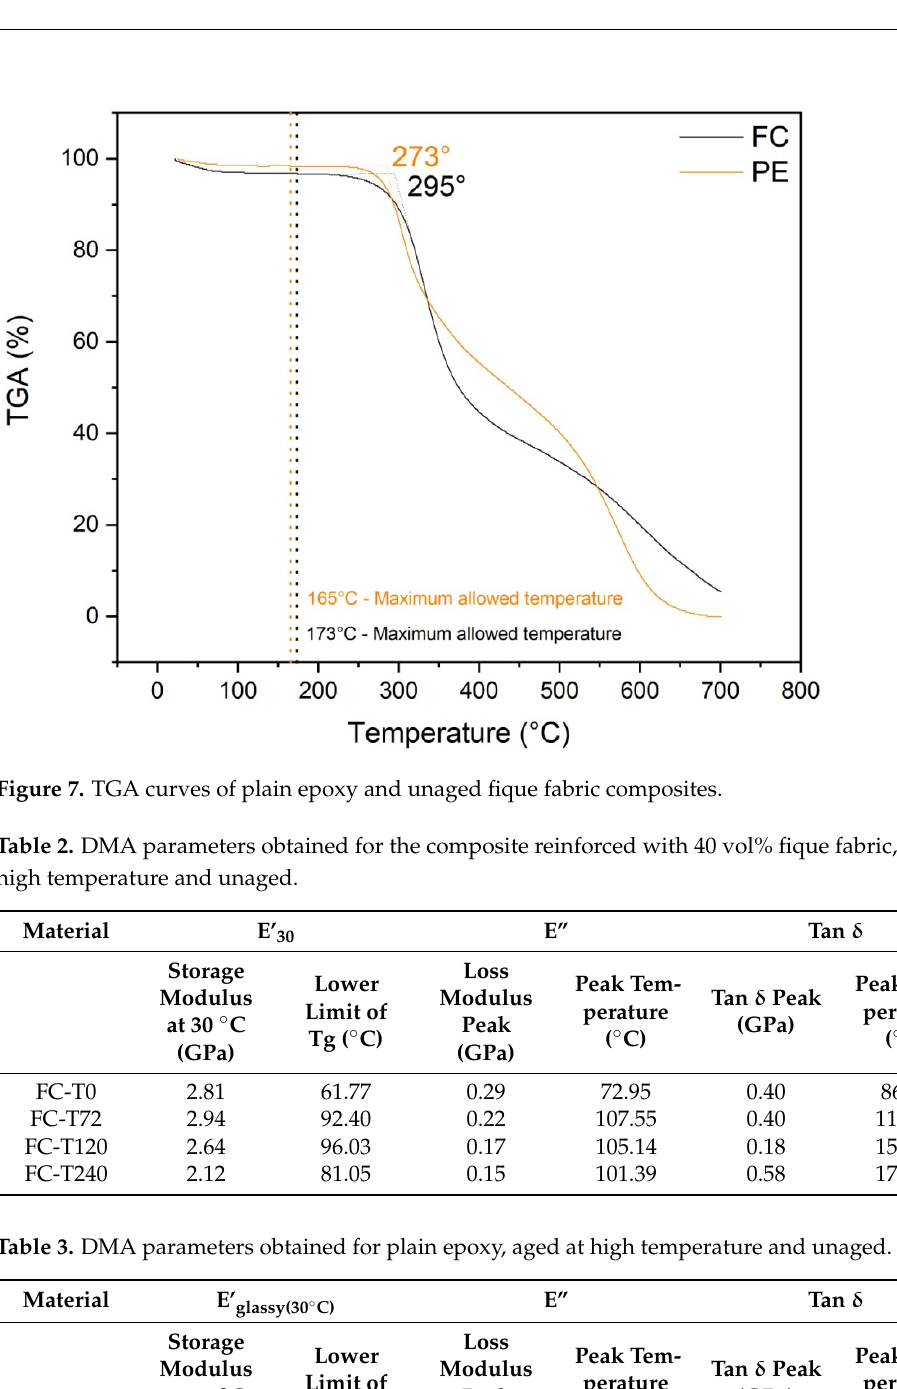
Table 3. DMA parameters obtained for plain epoxy, aged at high temperature and unaged.